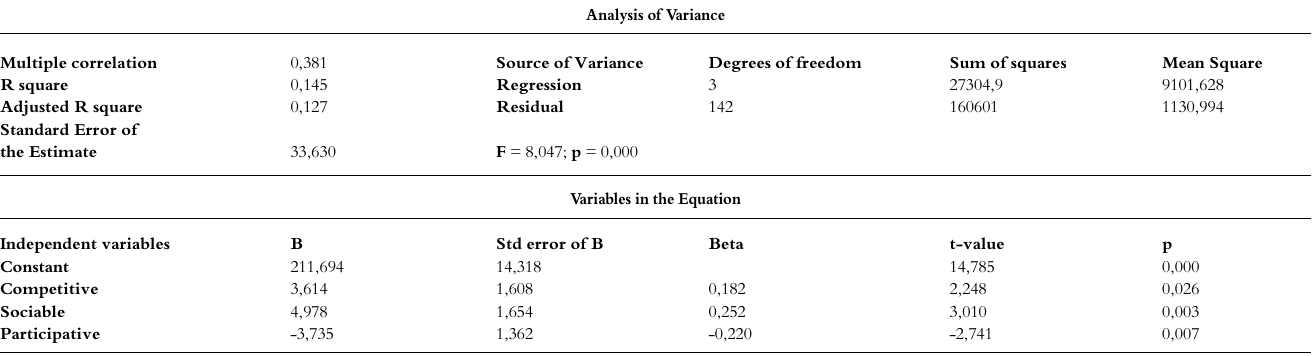
TABLE 5 Analysis of Variance